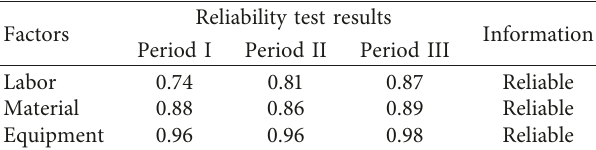
Table 9: Result of the reliability test of data